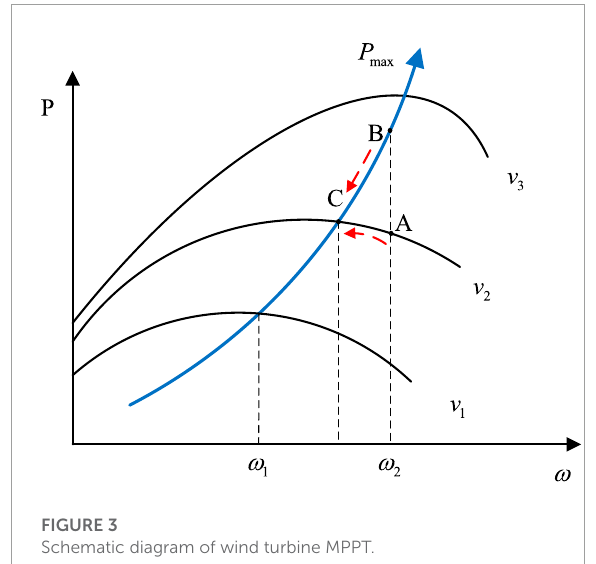
FIGURE 3 Schematic diagram of wind turbine